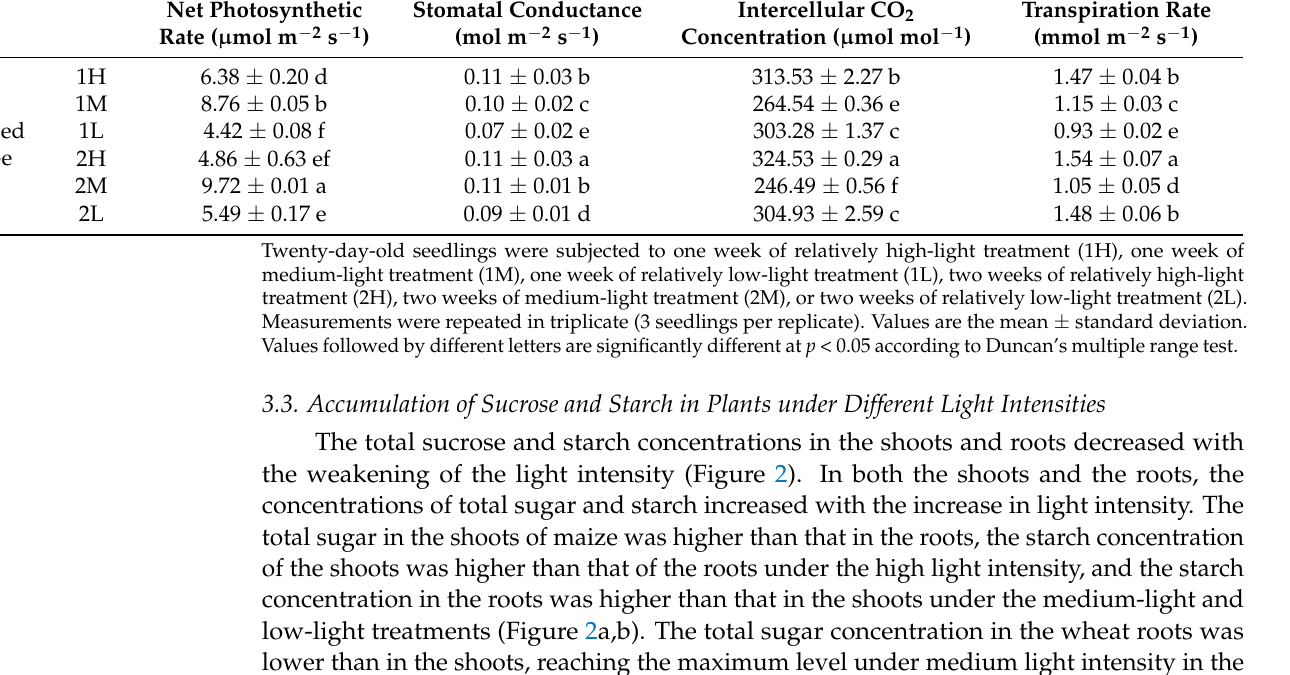
Table 3. The photosynthetic parameters of oilseed rape seedlings under different light conditions. Net